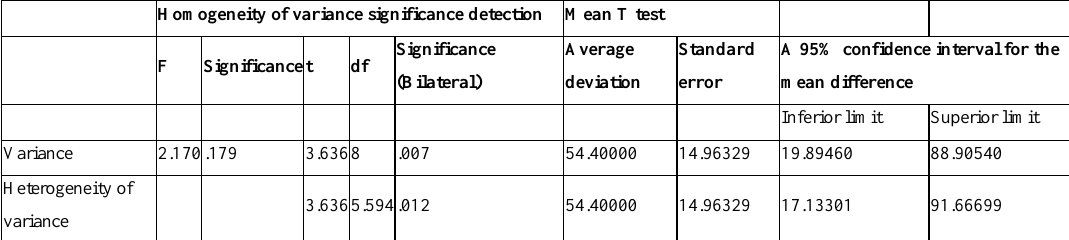
Table 1 Independent sample T test results (fixation count)